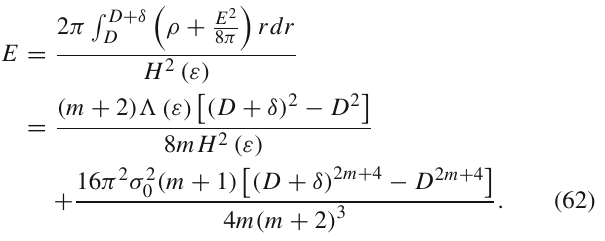
We use Eq. (61), to calculate the energy content within the thin shell region of the charged gravastar in gravity’s rainbow as